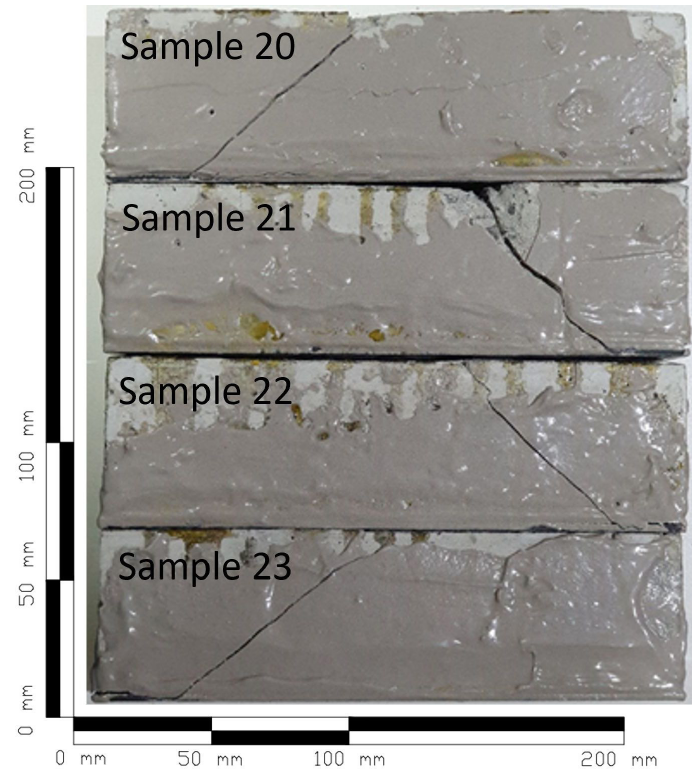
Figure 18. Cracking propagation behavior of FRP-C hybrid beams (Samples 20 to